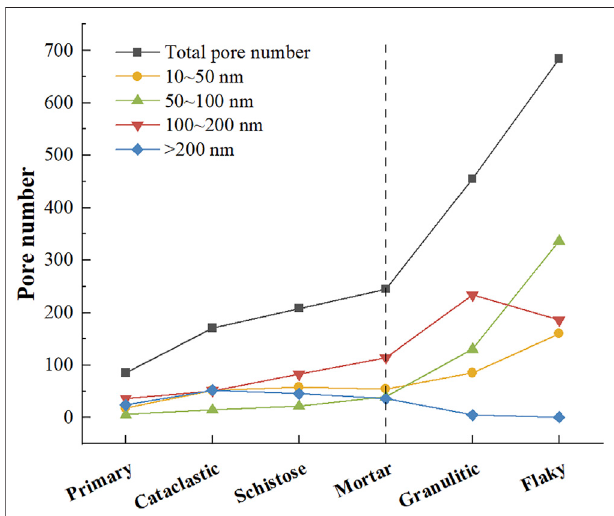
FIGURE 8 | Pore size distribution of coal samples from AFM.